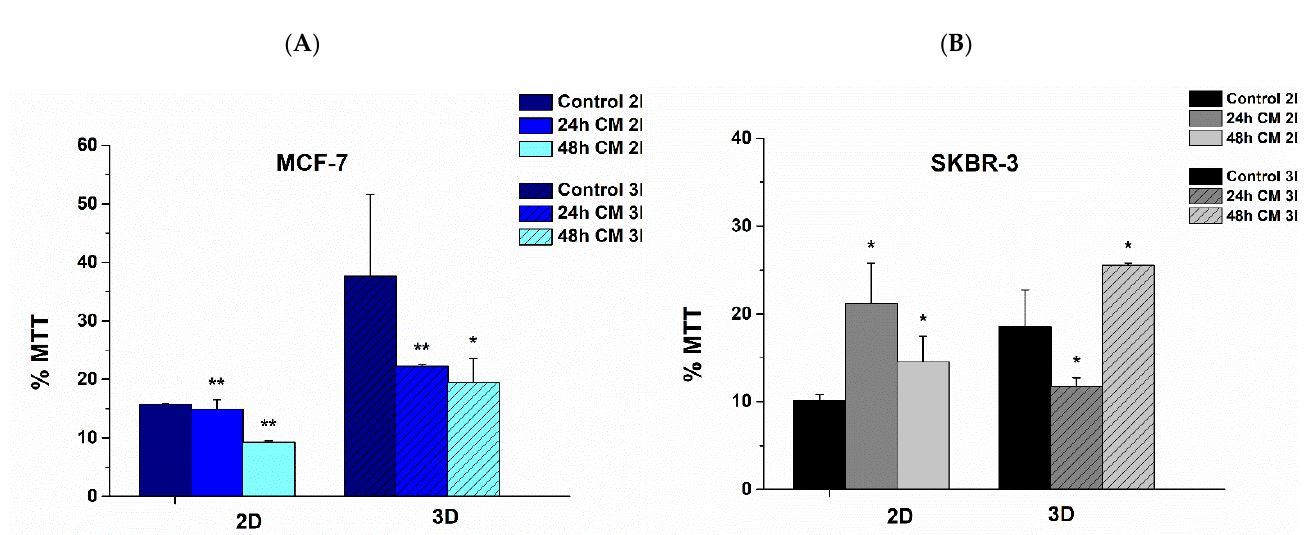
Figure 3. Cell viability of ( A ) MCF-7 and ( B ) SKBR-3 cells in dynamic conditions in both 2D surfaces and 3D PCL scaffolds. Data represents mean values ± SD of three independent experiments, * p < 0.05 and ** p <